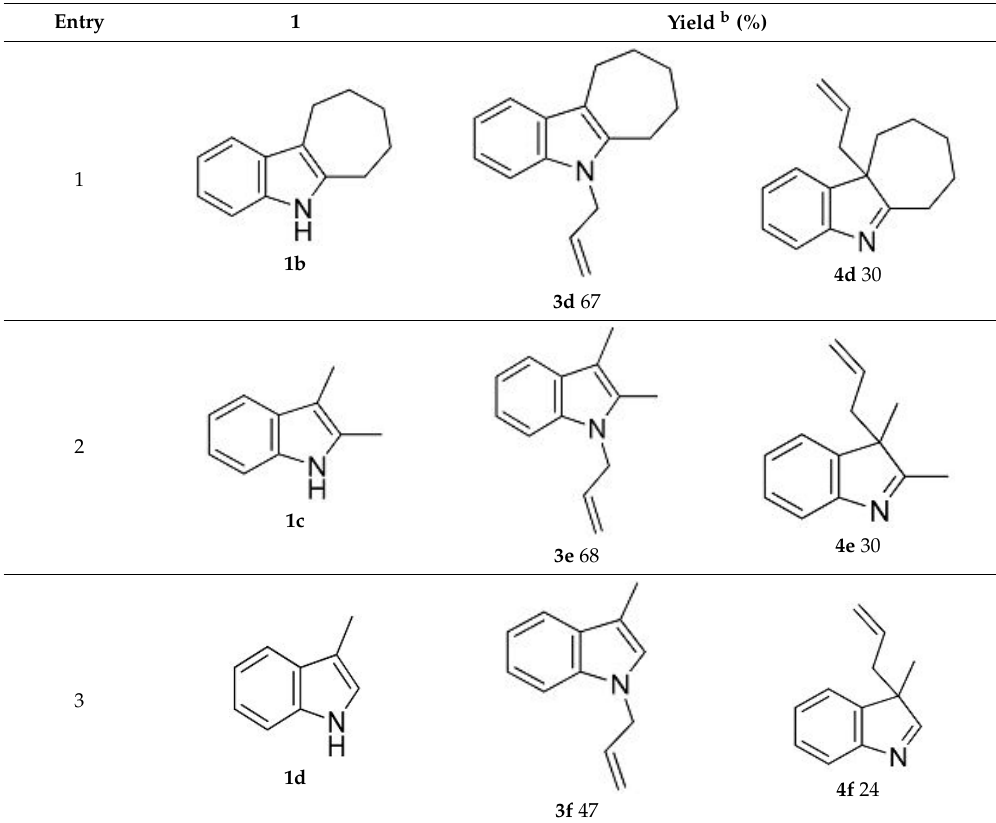
Table 3. Allylation of indoles ( 1 ) with allyl acetate ( 2a ).